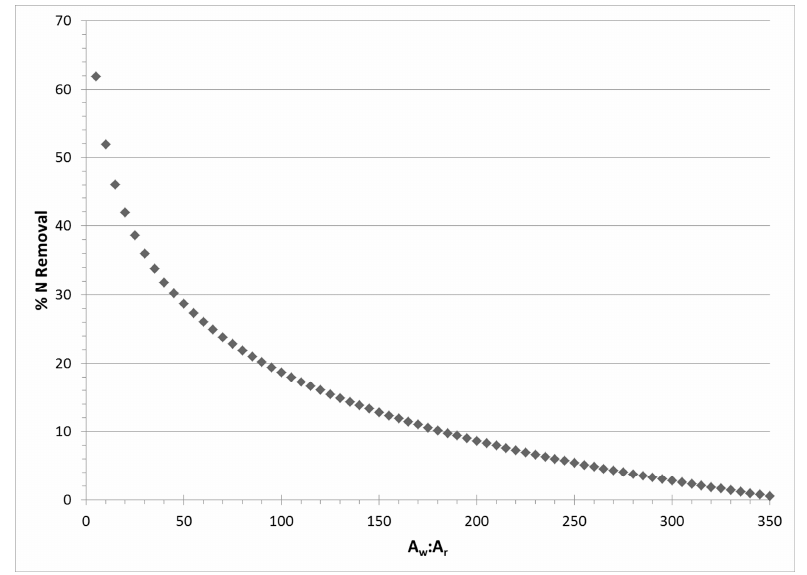
Figure 1. Nitrogen removal (%) versus watershed area: reservoir area ( A w : A r ) based on Equation (6) and an area normalized flow rate ( Q norm ) of 0.021 m 3 ∙ s − 1 ∙ km − 2 .